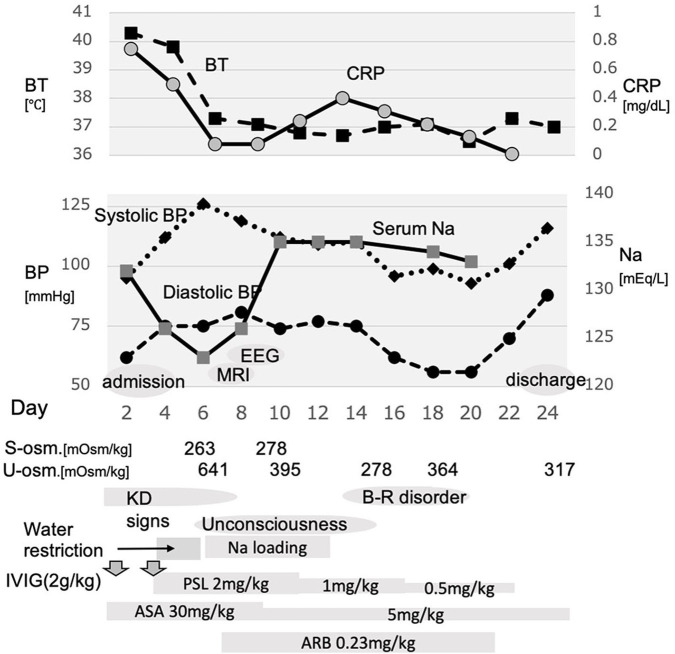
Schema of the course of this case. After admission and treatment with immunoglobulin, moderate fever sustained. Additional immunoglobulin combined with prednisolone was administered, which relieved fever; however, the serum Na level began to decrease, and the consciousness level worsened. Water restriction resulted in worsened hyponatremia. Thereafter, Na loading was started and resulted in improved consciousness and bladder–rectal function. BT, body temperature; BP, blood pressure; s-osm, serum osmolality; u-osm, urine osmolality; EEG, electroencephalogram; MRI, magnetic resonance imaging; KD, Kawasaki disease; B-R disorder, bladder–rectal disorder; IVIG, intravenous immunoglobulin; PSL, prednisolone; ASA, acetylsalicylate; ARB, angiotensin receptor blocker.